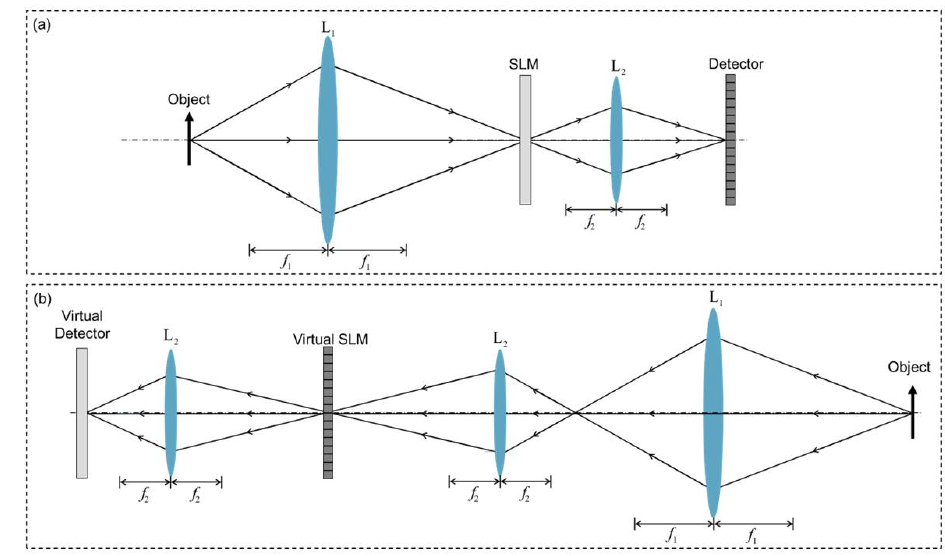
Figure 2. The imaging configuration of dual photography in the mode of structured detection: ( a ) the primal configuration; ( b ) the dual configuration.